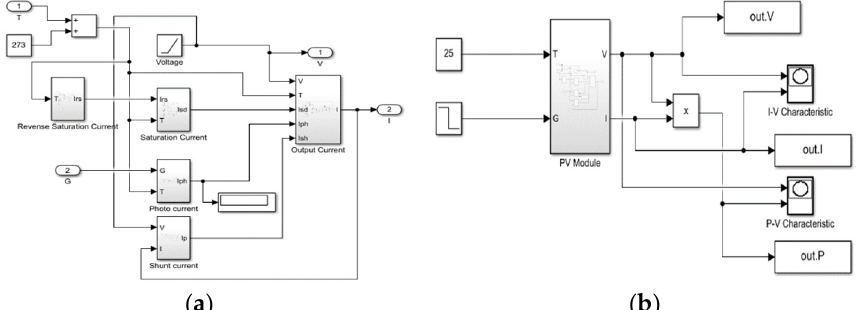
Figure 3. Internal battery simulation diagram: ( a ) mathematical model inside the photovoltaic cell; ( b ) packaging model of the photovoltaic cell. The test temperatures were 10 °C, 25 °C, 40 °C, and 60 °C. Figure 4b shows the rela- tionship between the output characteristics of the photovoltaic cells and light intensity when the ambient temperature remains unchanged at 25 °C. The tested light intensities were 250 W/m², 500 W/m², 750 W/m², and 1000 W/m². Comprehensive analysis indicated that the output characteristics of photovoltaic cells were easily affected by external envi- ronmental conditions, showing obvious nonlinear characteristics; the influence of light intensity on the maximum output power was far greater than that of environmental tem- perature on the maximum output power. It can be seen from Figure 4c that the hydrogen production rate of the alkaline electrolytic cell was proportional to the current of the elec- trolytic cell, and the hydrogen production rate per unit time also increased with the in- crease of the current.